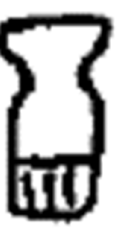
Figure 15. The Hieroglyphic Luwian logogram for SIGILLUM, “seal”.